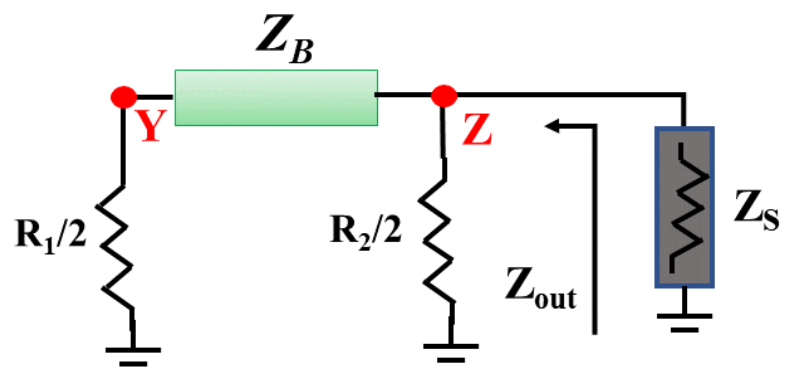
Figure 6. Transformed Odd-Mode Half-Circuit. For different values of Z B , (14) results in distinct sets of isolation resistor combinations. Figure 7 represents the variation of resistors for different values of Z B (for different values of θ c ) listed in Table